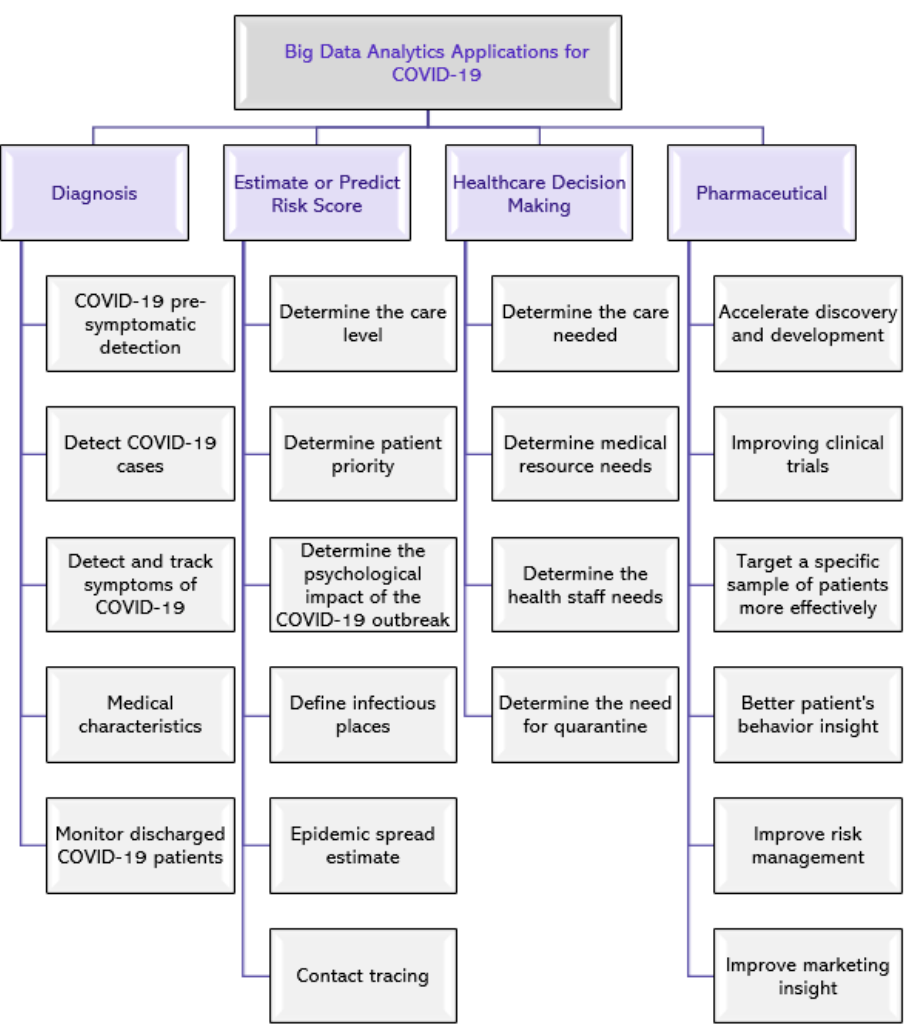
Figure 1. Potential application areas of big data analytics for COVID ‐ 19.